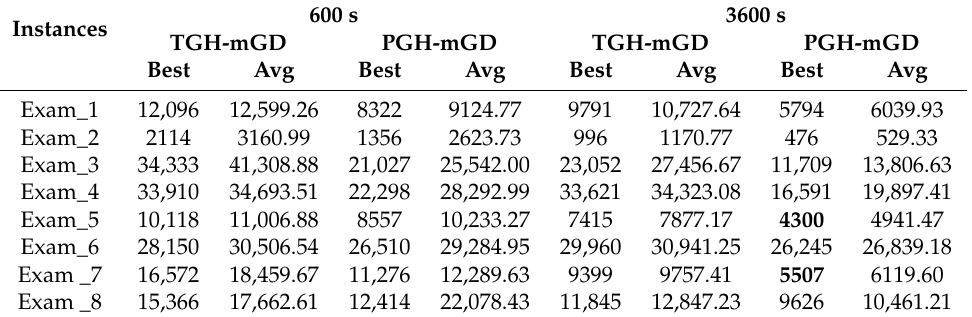
Table 7. For all of the eight instances, PGH-mGD produces better quality solutions compared